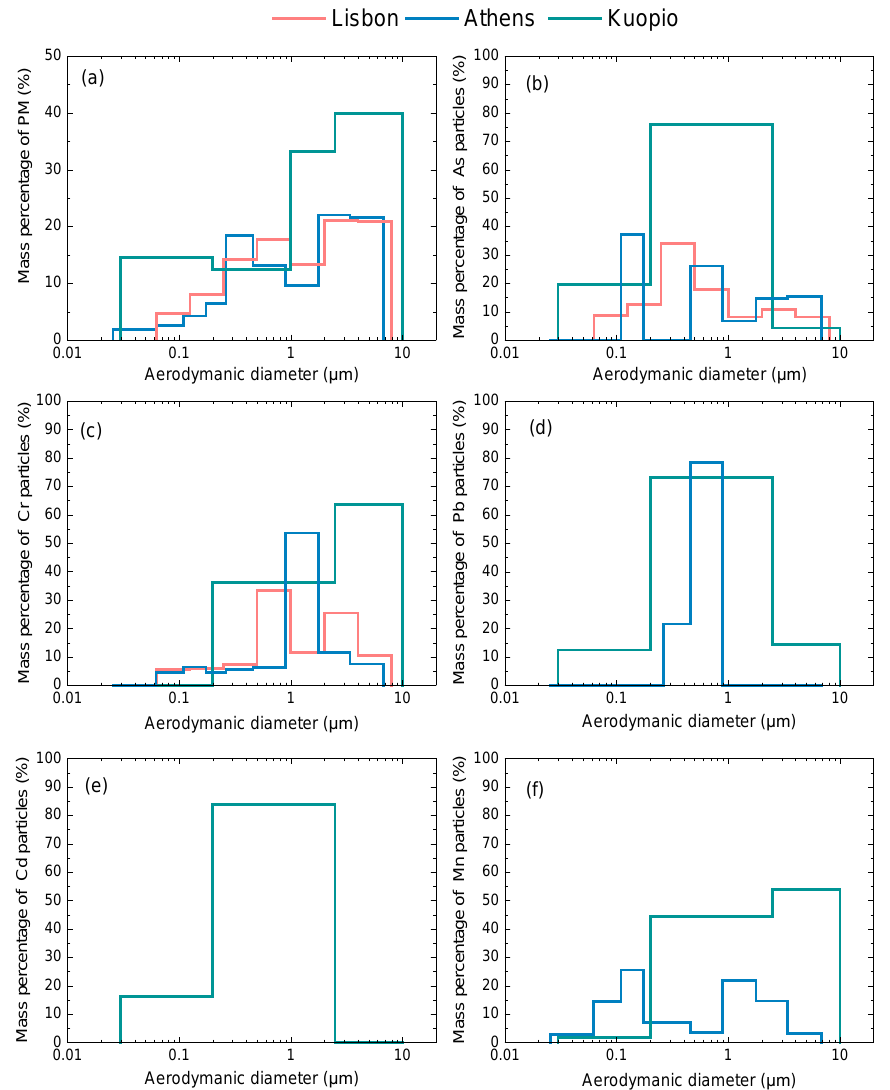
Figure 1. Size distribution of mass percentage for ( a ) particulate matter, ( b ) arsenic, ( c ) chromium, ( d ) lead, ( e ) cadmium and ( f ) manganese for the three European cities [54–56]. The size distribution data of Athens are unpublished.